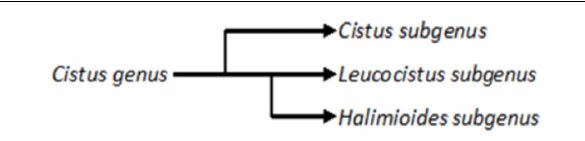
FIGURE 1 | Classification of three subgenus of Cistus genus based on analysis of trnF , matK and ITS sequences (Guzmán and Vargas, 2005) and plastid rbcL and trnL-trnF sequences (Guzmán and Vargas,